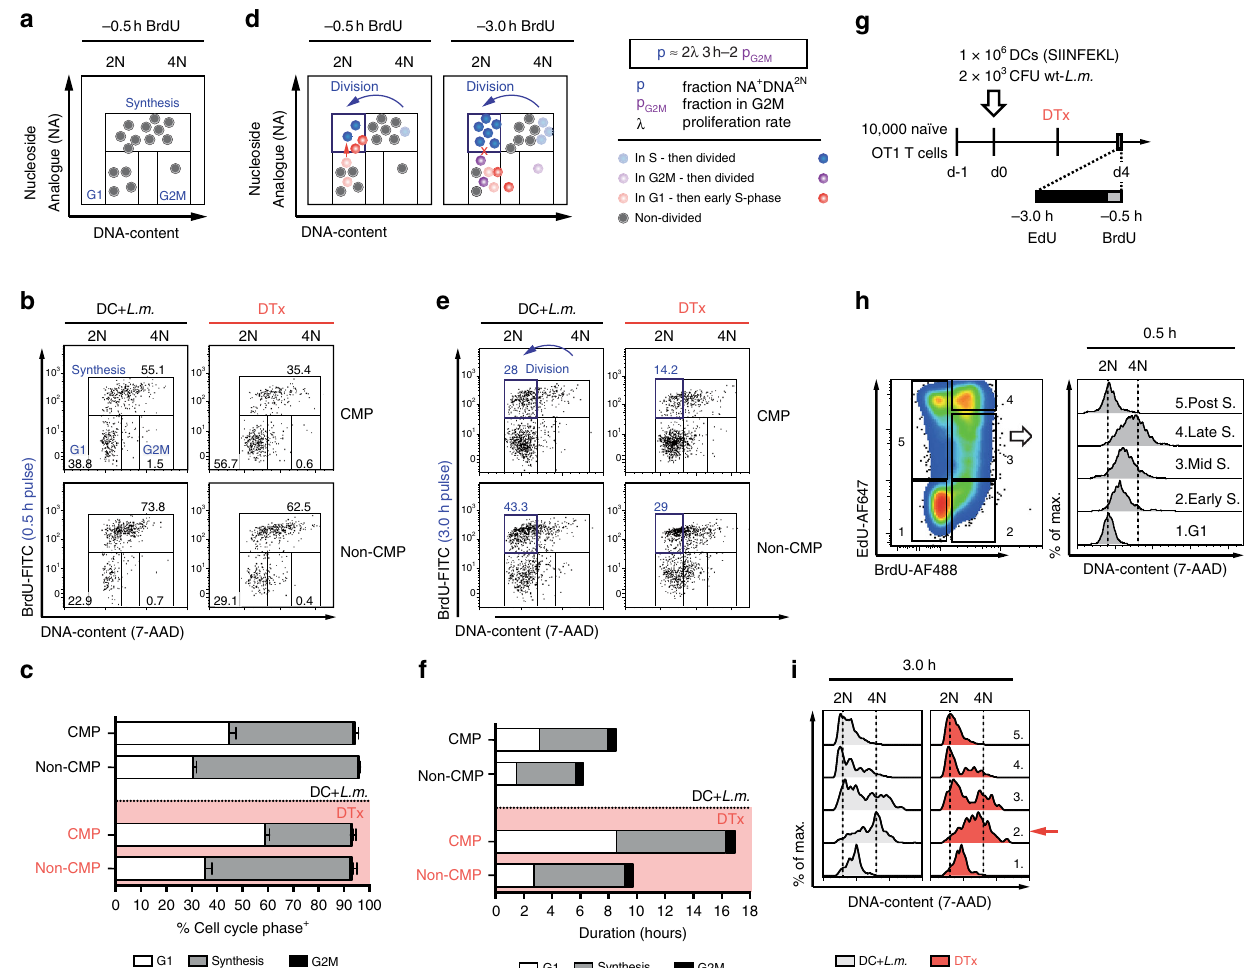
Fig. 4 Cell cycle speed of CMPs and non-CMPs is differentially regulated by elongation of G1- and S-phase. a Schematic representation of cells distributed throughout all active phases of the cell cycle in NA/DNA plots. b , c Experiments were performed as in Fig. 3f, but BrdU incorporation and 7- AAD staining of DNA content were analysed 0.5 h after BrdU injection. b Representative dot plots showing BrdU/DNA pro fi les of CD62L + (CMP) and CD62L − (non-CMP) cells derived from transferred T cells at day 4 after immunization (DC + L.m .), as well as after DTx treatment (DTx). c Bar graph depicts the percentage of cells in the indicated cell cycle phases (DC + L.m . and DTx, n = 4). d Schematic representation of cell cycle progression in BrdU/ DNA plots, for cells located in different cell cycle phases at the time of NA injection, as indicated (right, bottom panel). The mathematical formula to calculate the division rate λ from the fraction of cells in G2M and the NA + DNA 2N gate is given (right, upper panel). e As in b , but for analysis 3.0 h after BrdU injection. f Bar graph depicts calculated average division times and respective cell cycle phase lengths for the indicated T cell subsets derived from transferred T cells. g Scheme of the experimental setup used in h to track S-phase progression by sequential EdU and BrdU labelling. h Representative pseudo-colour plot showing the EdU/BrdU-pro fi le of transferred T cells with corresponding histograms depicting the DNA content for the indicated EdU/ BrdU-subpopulations (1 – 5); DNA labelling 0.5 h after BrdU pulse. i Representative overlayed histograms showing the DNA content for the same subpopulations; DNA labelling 3.0 h after BrdU pulse. Red arrow points to slower S-phase progression upon DC depletion. Lines indicate the mean, error bars the s.e.m. Data are compiled from two independent experiments ( b , c , e , f ) or are representative for one of two independent experiments ( h , i ). Source data are provided as a Source Data fi measured, should appear as NA + 2N (Fig. 4d, left panel, blue cells) and thereby, allow a quanti fi cation of the divided cell- fraction per time, i.e. of cell cycle speed. However, the short time frame of 0.5 h between NA administration and measurement of DNA content does not allow for suf fi cient separation of these divided cells from cells that have recently entered S-phase, which can also appear as NA + 2N (Fig. 4d, left panel, red cells). To achieve this separation, we increased the time gap between administering the NA and measuring DNA content to 3 h (Fig. 4d, right panel). Given an in vivo half-life of i.p.-injected BrdU in mice of only 0.5 h 30 , this increased time gap should suf fi ce to prevent T cells that have entered S-phase toward the tail end of the observation period from becoming NA + and thus,